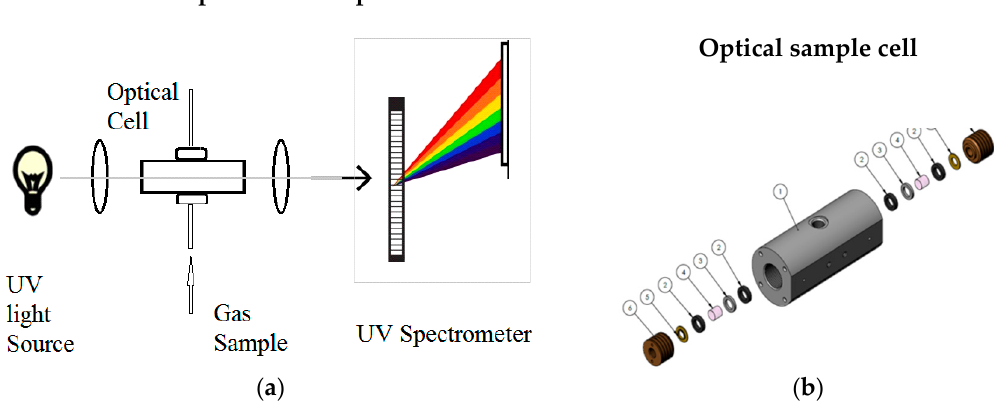
Figure 3. ( a ) Schematic setup of UV spectra collection experiment; ( b ) mechanical drawing of optical cell.